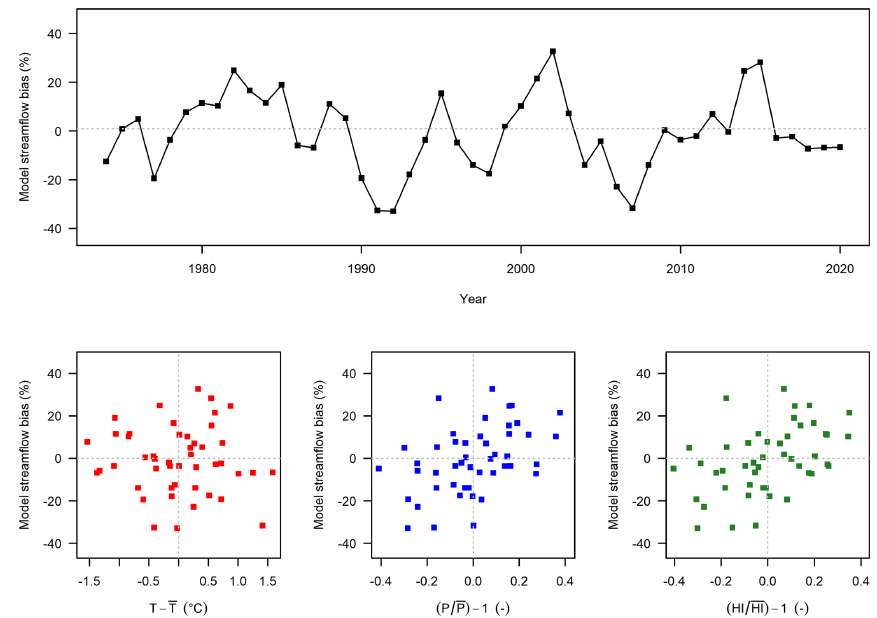
Figure 2. Robustness assessment test (RAT) applied to a hydrological model: the upper graph presents the evolution in time (year by year) of model streamflow bias; the lower scatterplots present the relationship between model bias and climatic variables (temperature T , precipitation P and humidity index HI, from left to right).